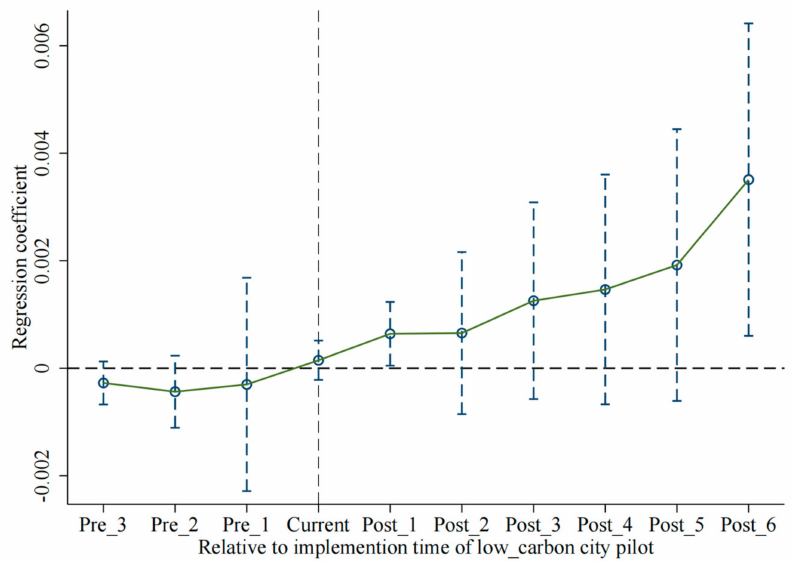
Figure 5. The dynamic effect